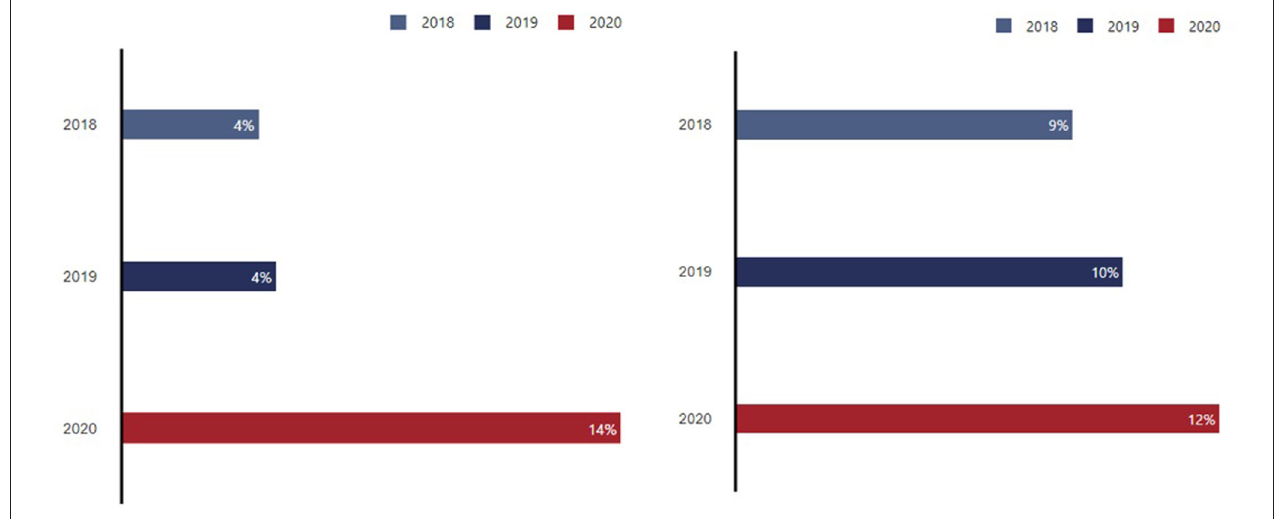
FIGURE 7 | Portion of Canadian adults who have ever had virtual video visit (left) or a virtual messaging visit (right) 2018–2020. Sourced from routine representative surveys of the Canadian population conducted in 2018, 2019 and 2020, with sample sizes ranging from 2,200 to 6,000 individuals (21).